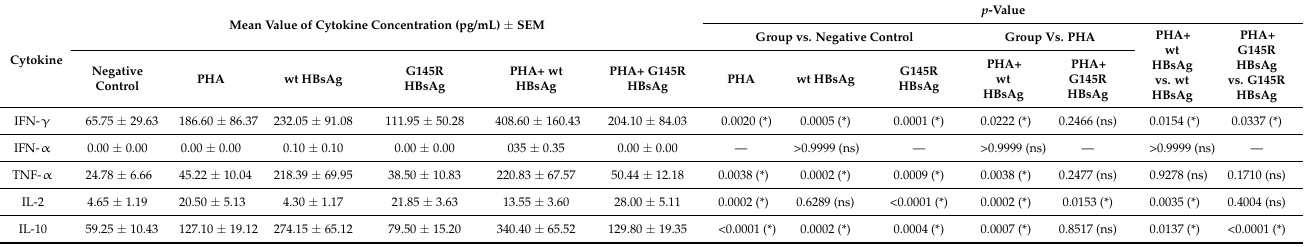
Table 4. Cytokine production in response to stimulation of PBMC from healthy donors with wild-type rHBsAg (ayw2) and the rHBsAg G145R mutant (ayw2) 1 .